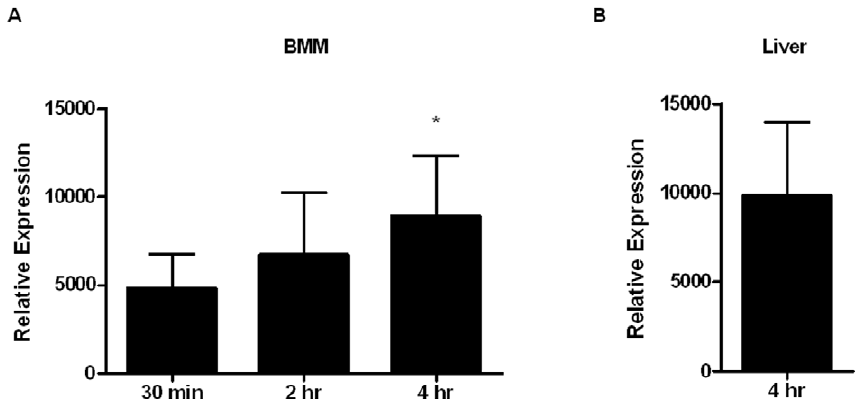
Figure 4. FTN_1133 is expressed during infection of macrophages and mice. Relative expression of FTN_1133 was determined in wild-type F. novicida -infected BMM (A) at 30 minutes, 1 hour, and 4 hours post-infection with an MOI of 20:1 and (B) in the livers of intraperitoneally-infected mice at 4 hours. Relative expression of FTN_1133 transcript was calculated by comparison with the expression levels of the DNA helicase uvrD ( FTN_1594 ). Data shown is representative of two independent experiments. Bars represent the standard deviation from each set of samples (n=5). Asterisk indicates significance compared to 30 minutes. (*) p , 0.05.